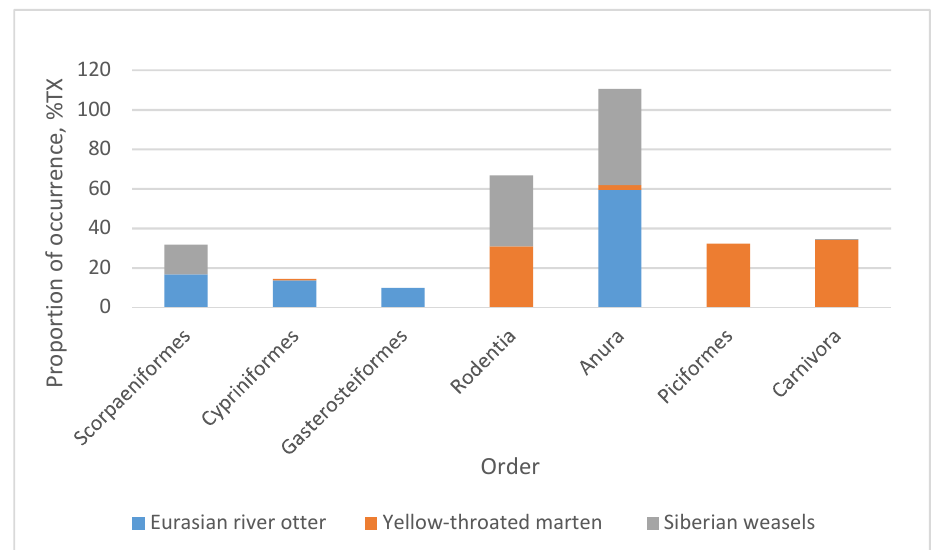
Figure 2. Vertebrate prey species molecularly identified in scats of three Mustelidae collected the Northeast Tiger Leopard National Park in northeast China.